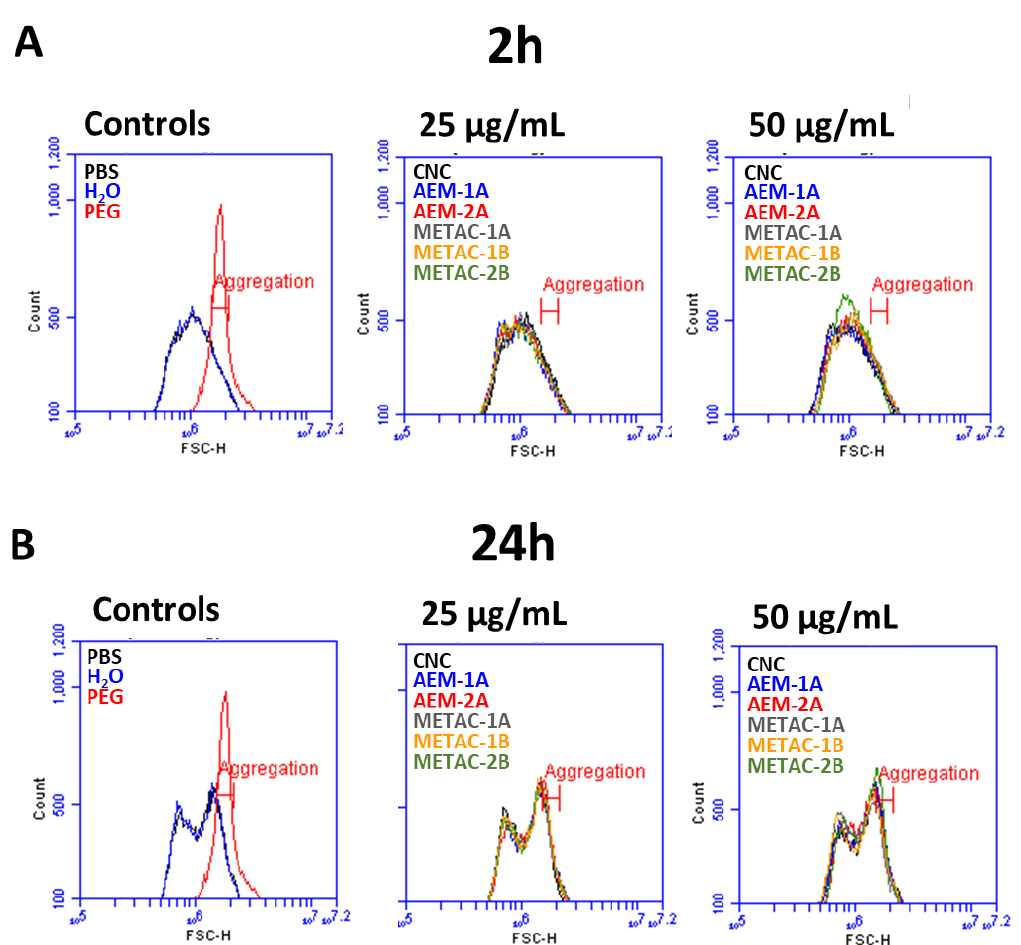
Figure 4. Effect of unmodified and modified CNCs on red blood cell (RBC) aggregation. Diluted human blood were treated for 2 h ( A ) or 24 h ( B ) with controls, PBS, ultrapure H 2 O, and PEG 1 mg/mL (2 h only), or with 25 µ g/mL or 50 µ g/mL of unmodified and modified CNCs. After respective treatments, RBC aggregation was accessed by flow cytometry. The histograms displayed the number of events vs. the FSC-H (forward light scatter) high channel (size estimation). The aggregation of RBC was gated using PEG 1 mg/mL (red, 2 h) for both 2 and 24 h time points ( A , B ).